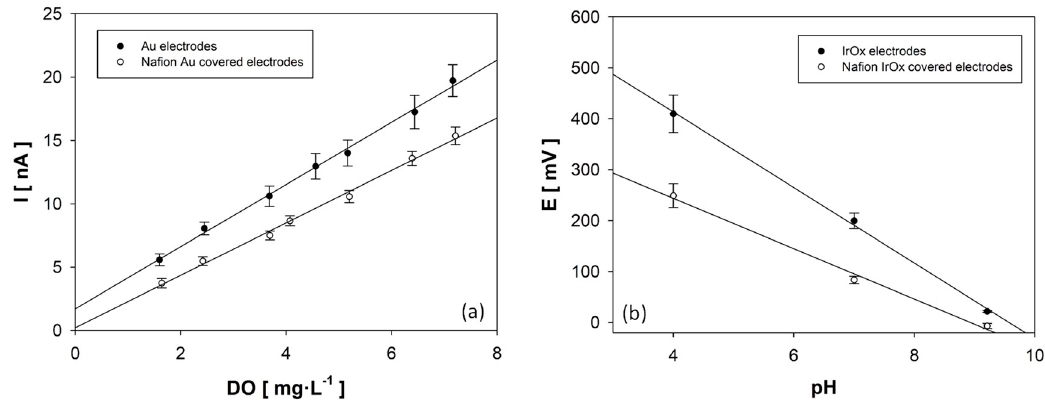
Figure 3. Calibration of the MEA sensor against DO ( a ), gold electrodes, and pH ( b ), IrOx electrodes. Calibrations were carried out before ( ● ) and after ( ○ ) the deposition of the Nafion ® membrane (n = 7). Calibration results obtained in naked needles displayed an excellent linearity (0.997) for oxygen detection between 0 and 8 mg·L − 1 of DO. The experimental sensitivity was quantified at 2.06 ± 0.08